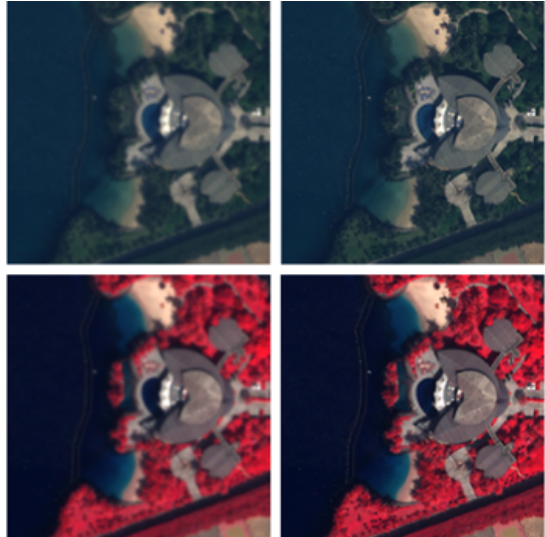
Figure 10 Results of our proposed approach on Pléiades Neo acquisition (multispectral bands at 120cm GSD). RGB and False Color Infrared are displayed. Left: L1B restored sensor with bicubic upsampling Right: proposed